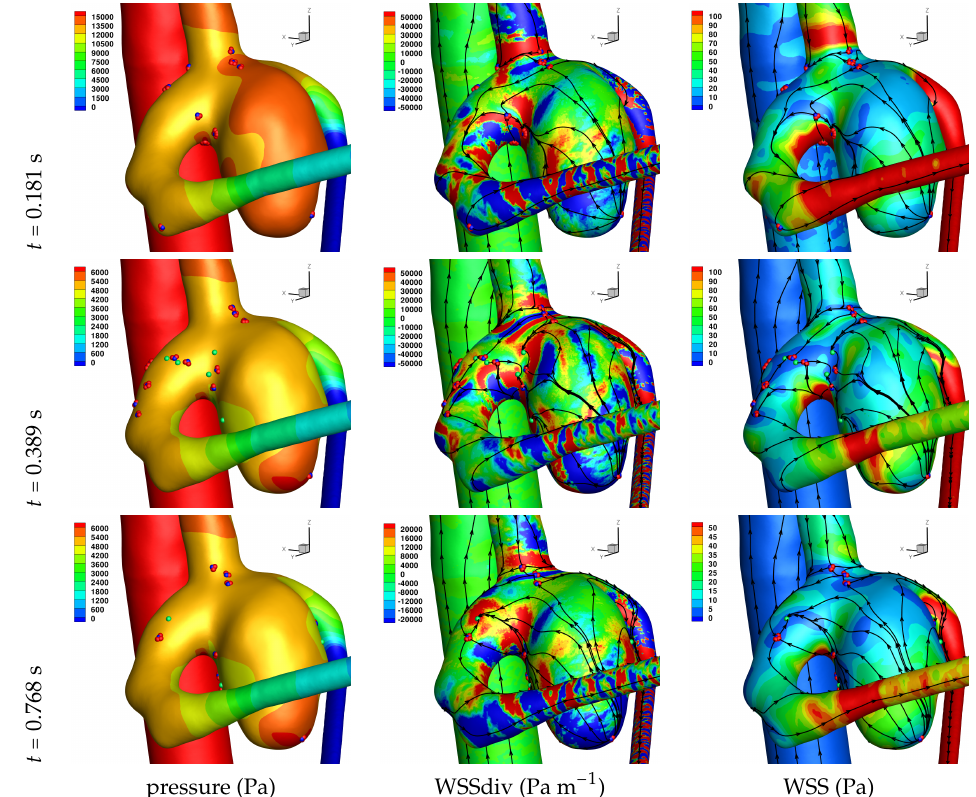
Figure 9. Solution for Case 6. Plots of surface shear lines and WSS critical points (colouring scheme as in Figure